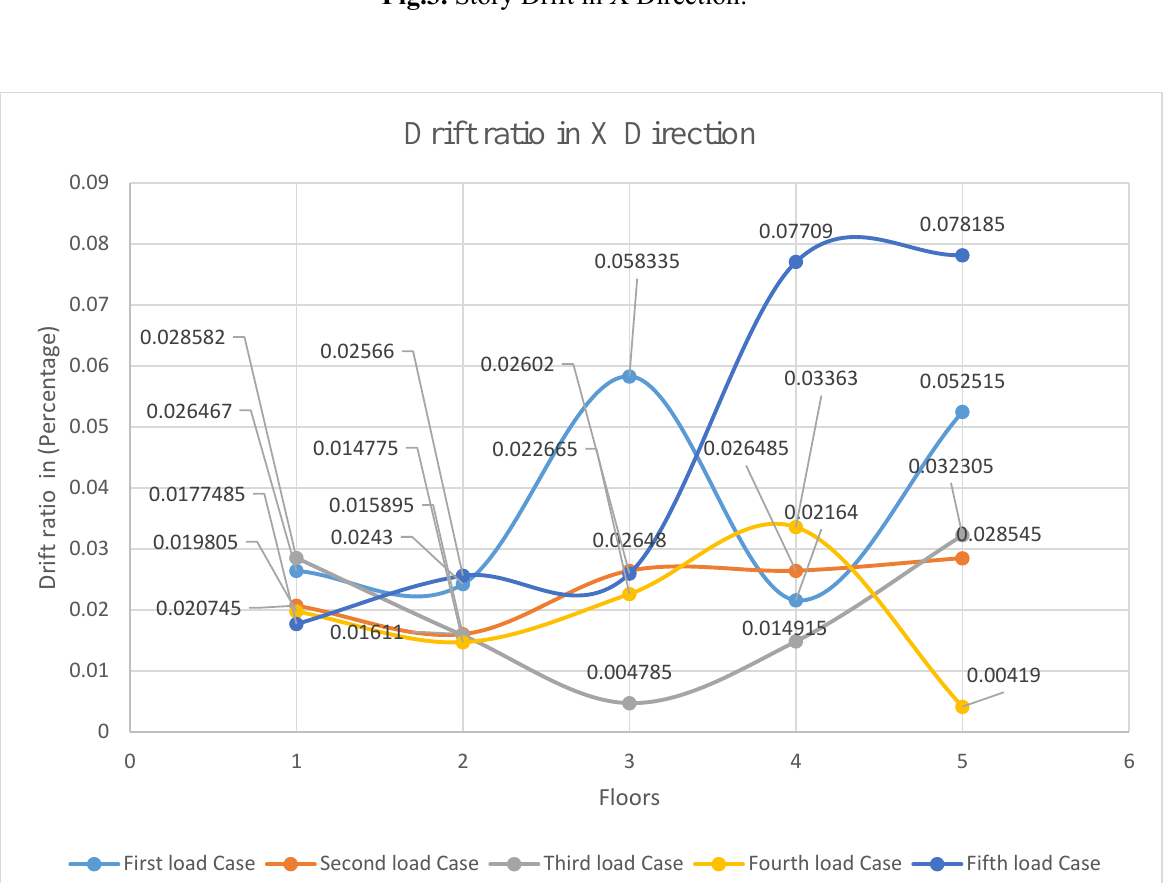
Fig.3. Story Drift in X Direction.